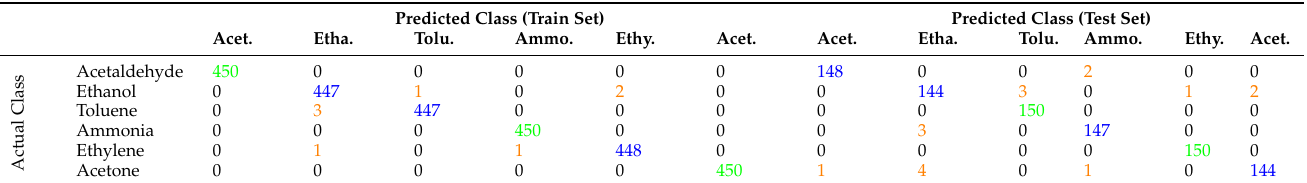
Table 8. Confusion matrix for the UMAP-ELM training and test sets for dataset #1 (for the ELM activation function